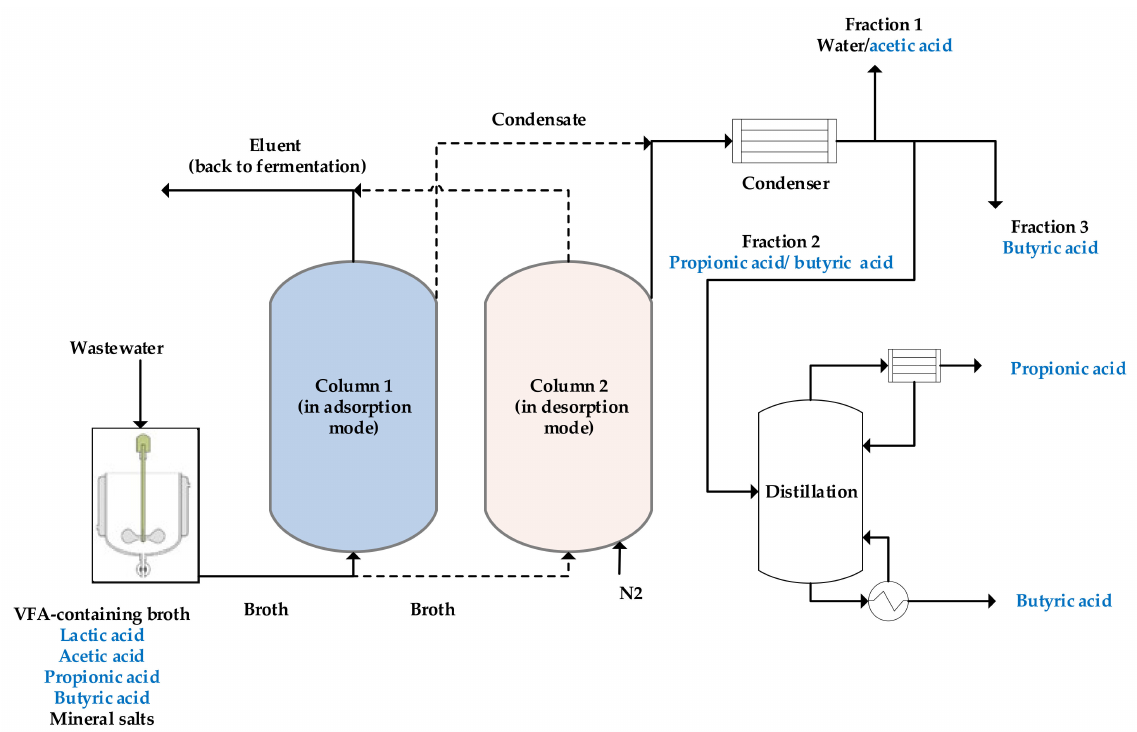
Figure 4. Schematic view of adsorption-thermal desorption process to recover VFAs from a fermenta- tion broth, redrawn from the work of [36] with permission from the American Chemical